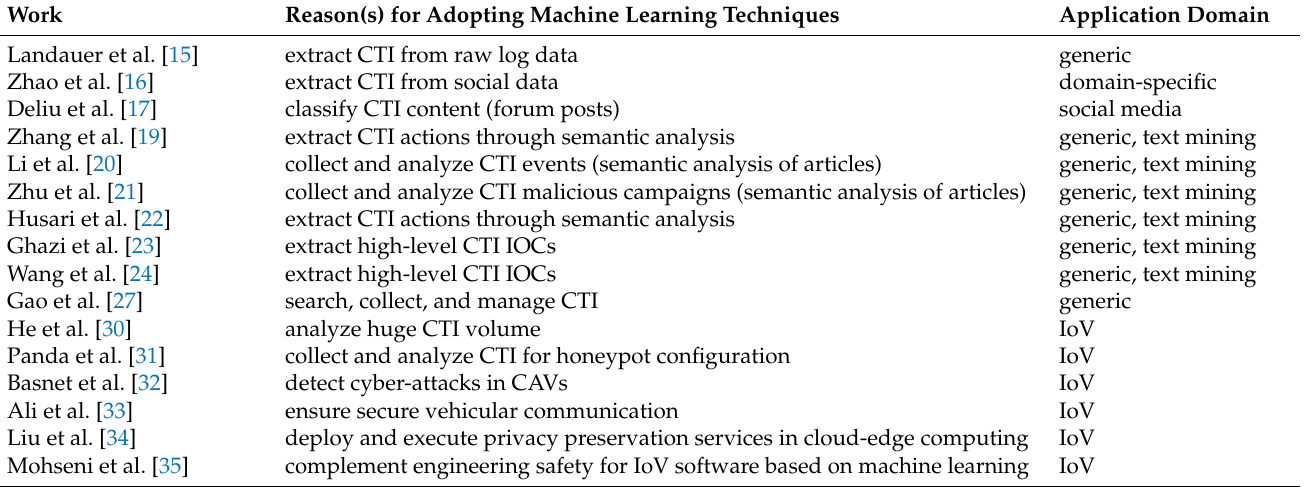
Table 1. Related